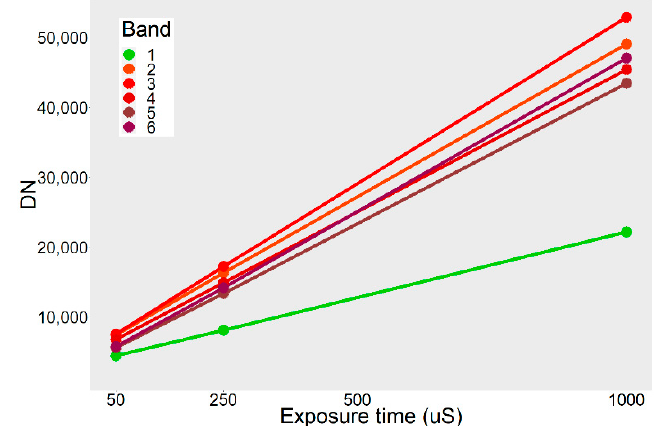
Figure 9. The linear response of the camera at 40% of the integrating sphere source maximum